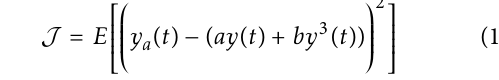
Figure 3. Evolution of γ with respect to γ d of δ , ( p h ; p h ) = (0 . 1 ; 0 . 9) f a d